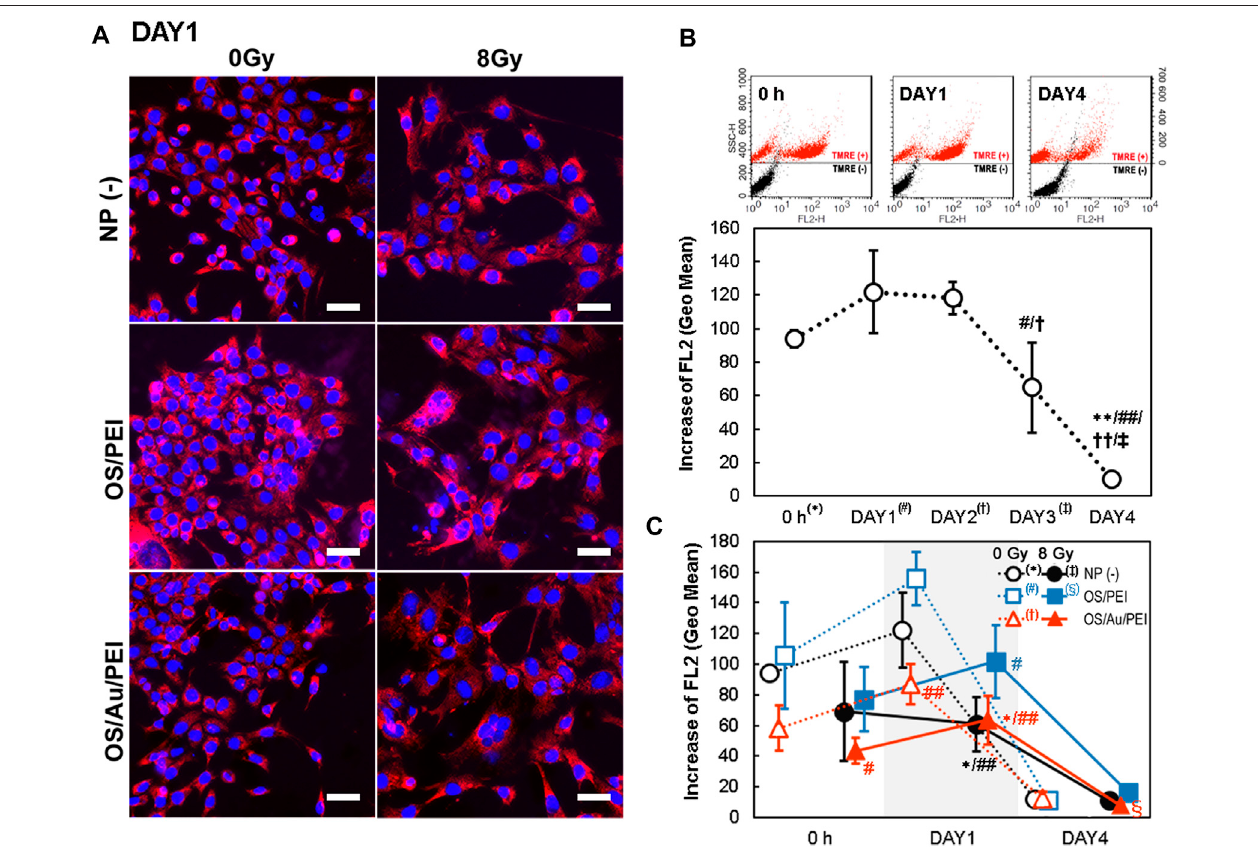
FIGURE 6 | (A) TMRE stained FM images of 4T1 cells at DAY1 after X-ray irradiation. 4T1 cells were treated with NP (-), OS, OS/PEI, OS/Au/PEI, and 0 and 8 Gy, respectively.Scalebar=50 μ m. (B) Time-dependenceof fl owcytometricanalysisof4T1cellswithNP(-)andstainedwithTMRE.(Upper)TheSSCvaluesofcellsstained with and without TMRE are presented on the left and right sides, respectively. (Lower) Increases in FL2 were calculated by subtracting the fl uorescence intensity (geo mean) of cells treated with NPs and stained with TMRE from the control cells treated with NPs but not stained with TMRE. Each value represents mean SD, where n = 3 replicates. * Signi fi cantly different from the 4T1 cells at 0 h # Signi fi cantly different from the 4T1 cells at DAY1. † Signi fi cantly different from the 4T1 cells at DAY2. ‡ Signi fi cantlydifferentfrom the4T1 cells at DAY3. (C) Time-dependence of fl owcytometricanalysisof4T1 cells with NP(-), OS/PEI, and OS/Au/PEI with or without X-ray irradiation,andstainedwithTMRE.*Signi fi cantlydifferentfromthe4T1cellstreatedwith0 GyNP(-).#Signi fi cantlydifferentfromthe4T1cellstreatedwith0 GyOS/PEI. † Signi fi cantlydifferentfromthe4T1cellstreatedwith0 GyOS/Au/PEI. ‡ Signi fi cantlydifferentfromthe4T1cellstreatedwith8 GyNP(-).§Signi fi cantlydifferentfromthe 4T1 cells treated with 8 Gy